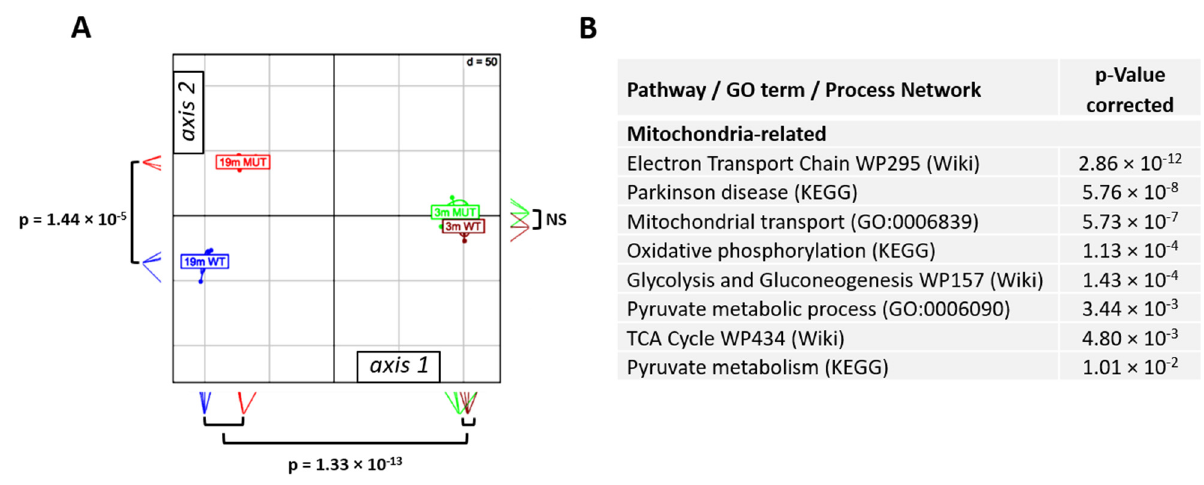
Figure 1. Brain transcriptome analysis. ( A ) Between group analysis (BGA) scatter plot for brain transcriptome profiles ( n = 4 for three months old MRPS5 WT —brown; n = 4 for three-month-old MRPS5 V338Y —green; n = 4 for 19-month-old MRPS5 WT —blue; n = 4 for 19-month-old MRPS5 V338Y —red; NS—not significant). ( B ) Gene enrichment analysis comparing 19-month old MRPS5 V338Y and MRPS5 WT mice, terms and significance for selected upregulated gene transcripts in mutants, adjusted p -values are shown.